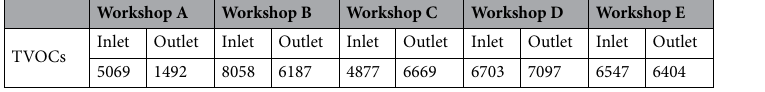
Table 3. Total volatile organic compound (TVOC) concentrations at the inlet and outlet of the painting booths during topcoat application (unit: